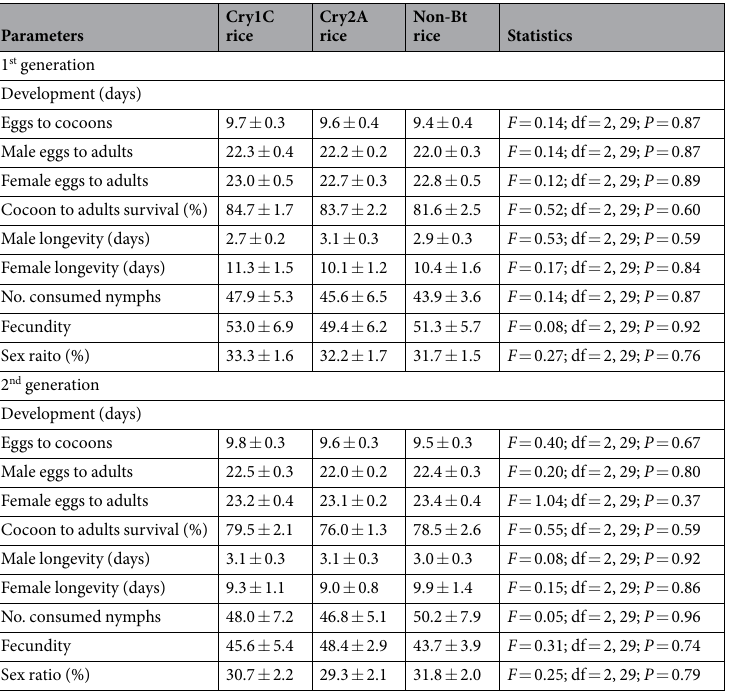
Table 1. Tri-trophic effects on life-table parameters (mean ± SE) of Pseudogonatopus flavifemur when provided Nilaparvata lugens nymphs that were reared on Cry1C, Cry2A or non-Bt rice plants over two generations. Ten replications were tested for each treatment. No significant difference was found among treatments based on one-way ANOVA ( P <